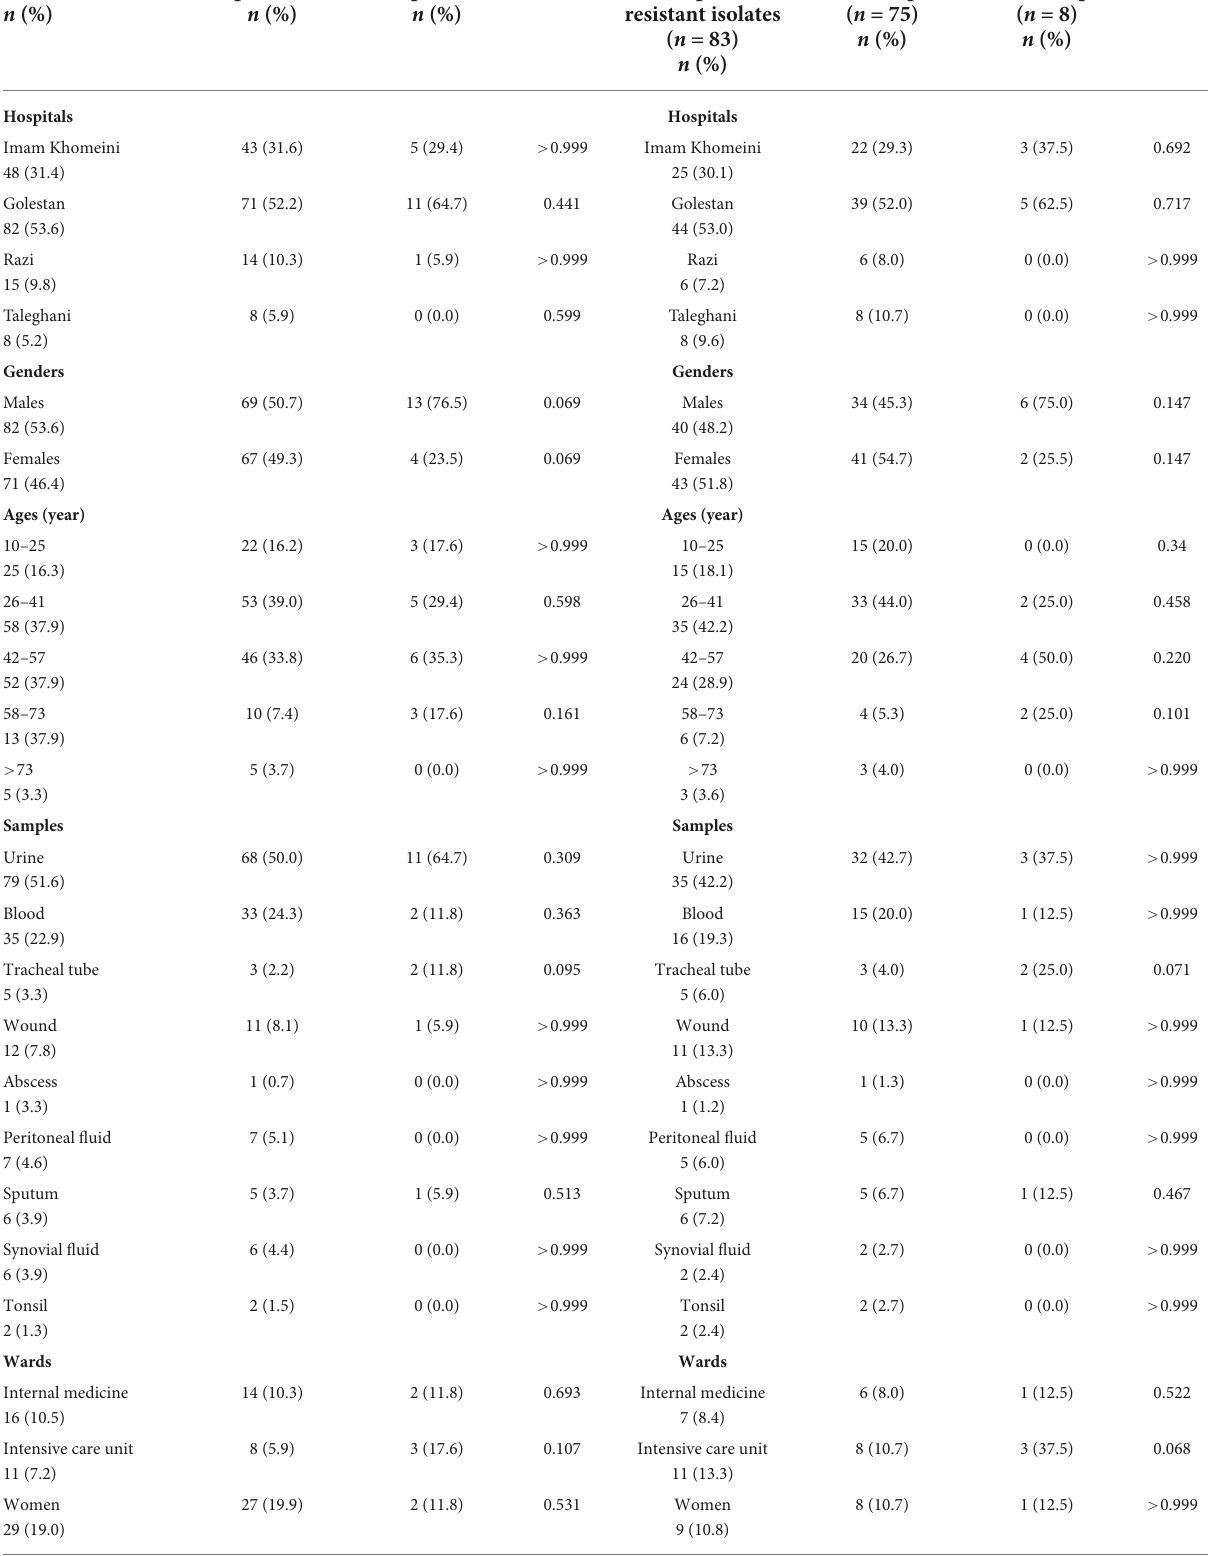
TABLE 4 The frequency of classic Klebsiella pneumoniae (cKp), hypervirulent K. pneumoniae (hvKp), carbapenem-resistant classic K. pneumoniae (CR-cKp), and carbapenem-resistant hypervirulent K. pneumoniae (CR-hvKp) isolates according to hospitals, ages, genders, samples, and